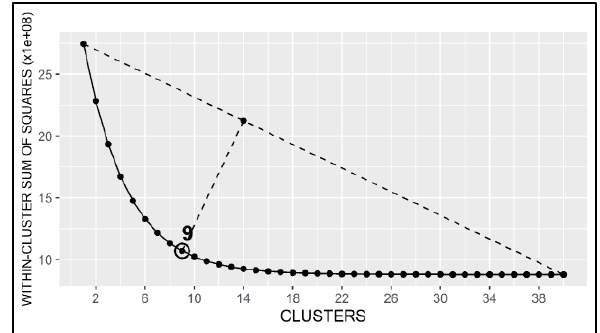
Figure 7. Optimal number of clusters determination with elbow method.